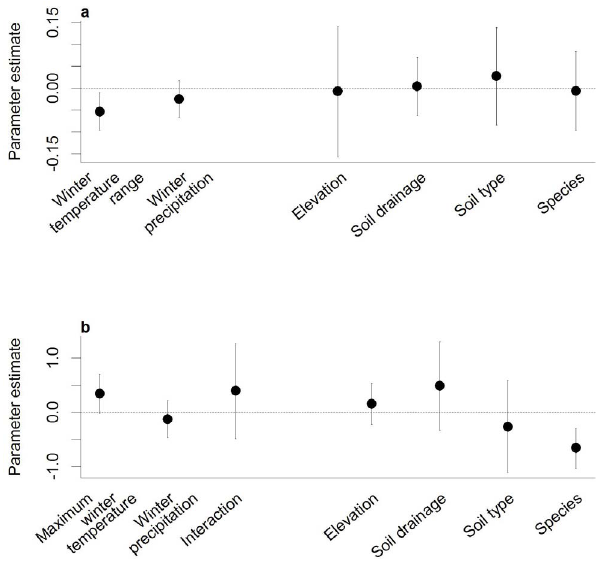
Figure 2. Results from the a) linear regression model for growth and b) logistic regression model for age-class structure fit within a Bayesian framework. The mean (filled dots) and 95% credible intervals (solid lines) for the parameter estimates describe the effect of each explanatory variable on plot-level annual growth rates. Categorical variables are relative to a reference class (good soil drainage, eutrophic soil type, D. scoparium species) as described in the Methods section. Credible intervals crossing the zero line (dashed) are not significant.